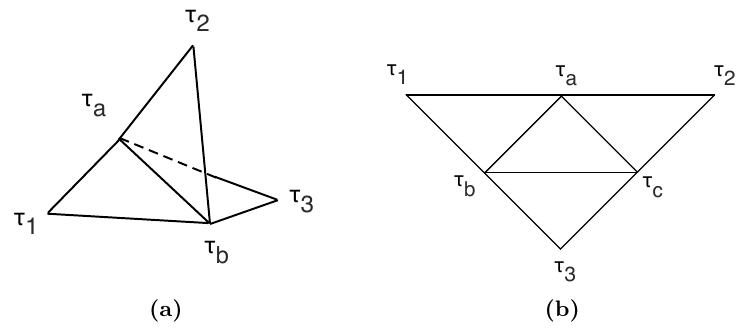
Figure 7. The integrals I (1) (3.10) and I (2) (3.15), relevant for the three-point function of the nmk nmk fermion bilinears, can be viewed as three-loop and four-loop integrals,